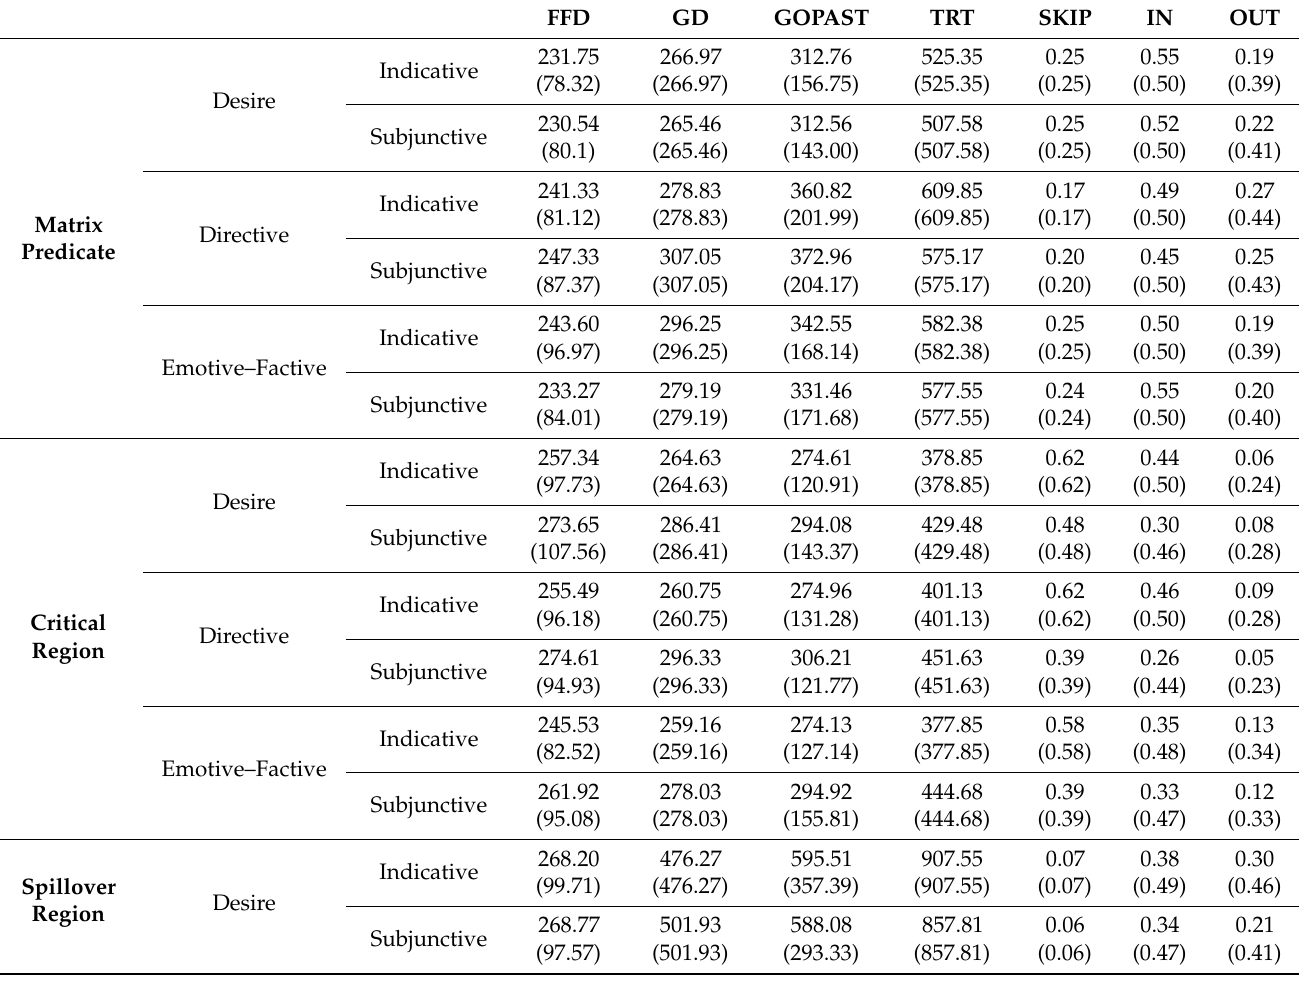
Table 6. Reading time measures for L2